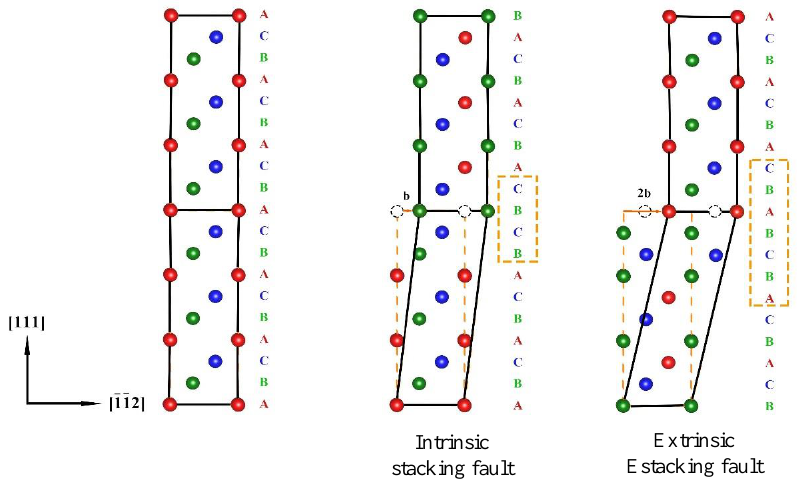
Figure 2. Tilted supercell model for SFE calculations.